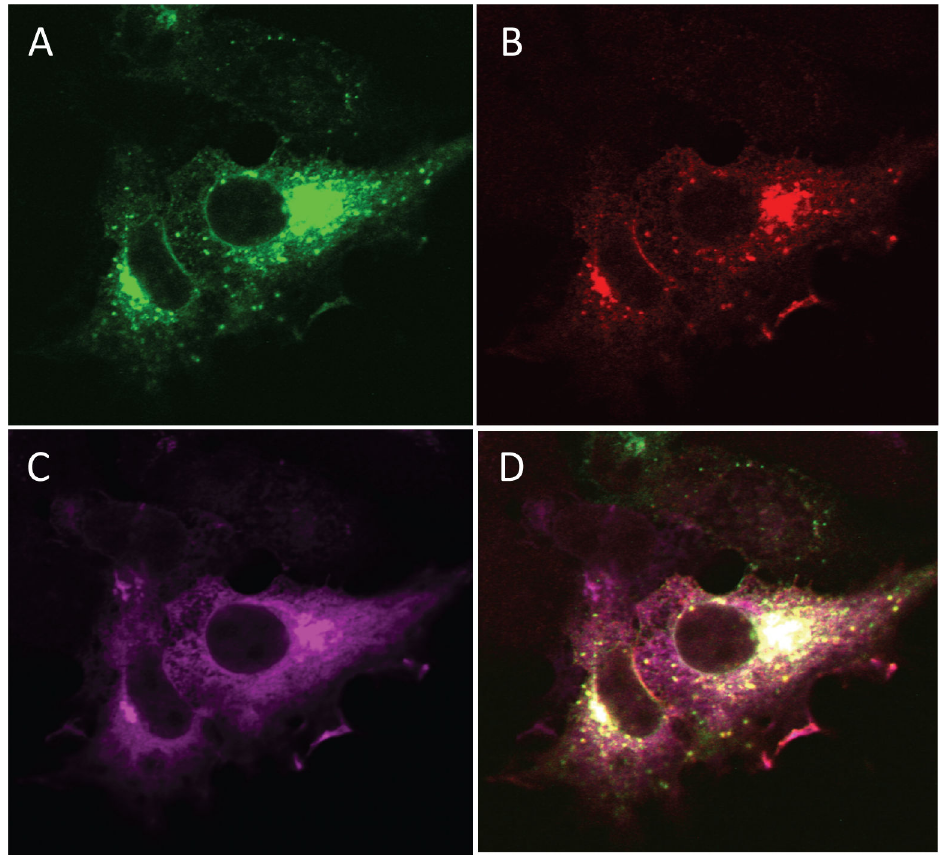
Figure 2. Co-localization of MARCH2, STX6, and CAL. HEK293 cells grown on coverslips were co-transfected with 3µg GFP- STX6, 3µg myc-CAL, and 1µg HA-MARCH2. After 24 h, cells were fixed and subjected to indirect fluorescent immunocytochemical staining with an anti-myc rabbit polylonal antibody and an anti-HA mouse monoclonal antibody followed by goat anti-rabbit Alexa Fluor 647-conjugated secondary antibody and goat anti-mouse Alexa Fluor 594-conjugated secondary antibody. ( A ) GFP-STX6 appears in green. ( B ) HA-MARCH2 appears in red. ( C ) myc-CAL appears in magenta. ( D ) Overlay of GFP-STX6, HA-MARCH2 and myc-CAL. Data shown are representative of at least three independent